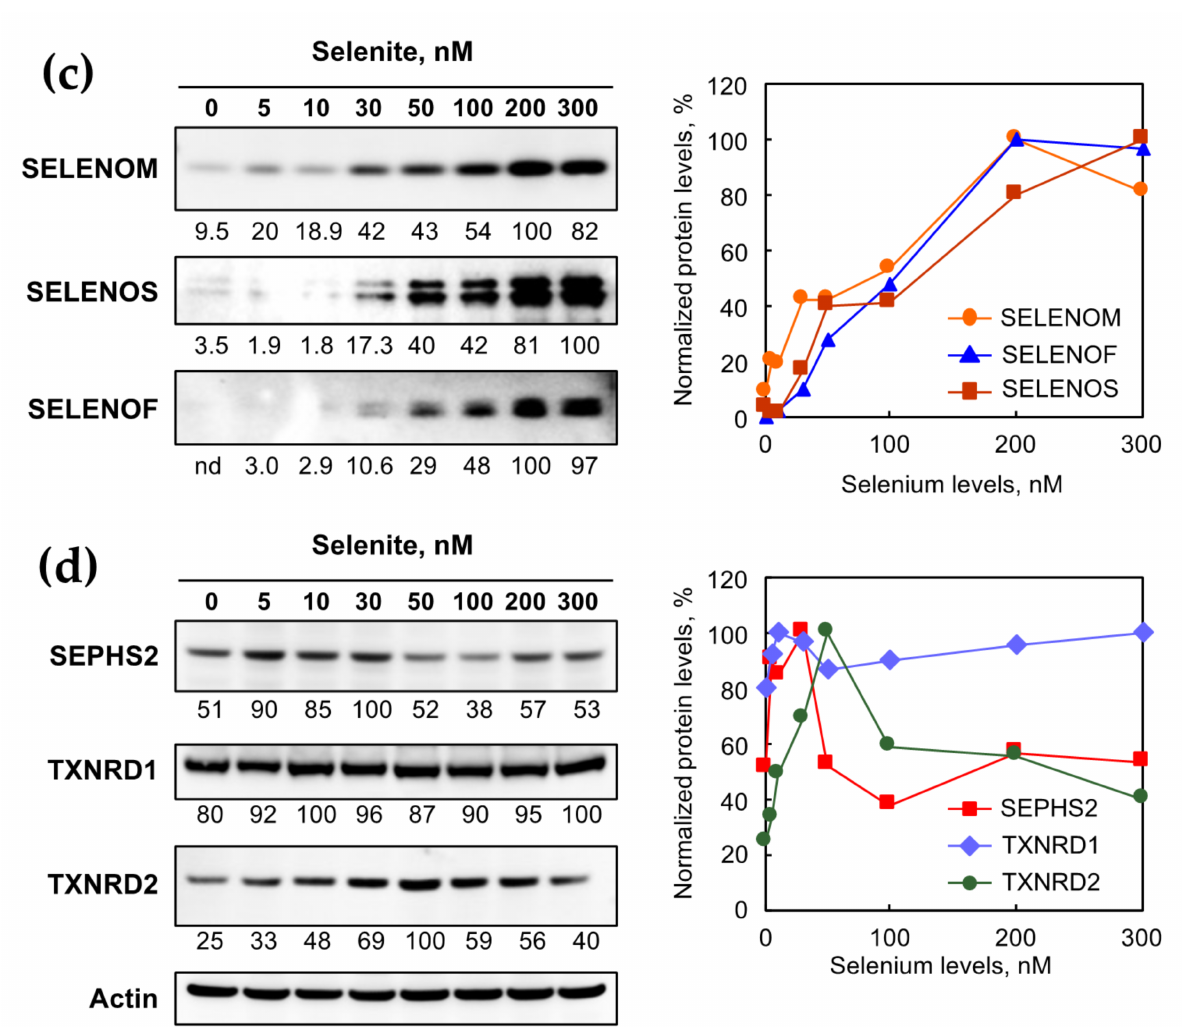
Figure 3. Analysis of selenoprotein expression as a function of selenium levels. ( a ) The response of selenocysteine insertion efficiency to selenium levels depends on the nature of the SECIS element. Two HEK293 cell lines stably expressing luciferase-based reporter constructs varying from the nature of the SECIS element, GPX1 and GPX4, respectively, were grown with increasing concentrations of selenium in the culture media. The structure of the Luc UGA/SECIS constructs was schematized. The Sec insertion efficiency was revealed by the luciferase activity normalized over the amount of proteins in cellular extracts. In both cell lines, the Sec efficiency is expressed relative to the one measured in the Dpl condition, set as 1. The HEK293 cell extracts with increasing amounts of 76 Se selenite (similar to Figure 2) were also analyzed by western immunobotting for the presence of selenoproteins GPX1, GPX4, SELENOP, and SELENOO ( b ), SELENOM, SELENOS, and SELENOF ( c ), and SEPHS2, TXNRD1, and TXNRD2 ( d ). Relative quantification of individual selenoprotein over actin is indicated at the bottom of the corresponding immunoblot, with maximum intensity set at 100. The quantification results are also represented as a function of selenium levels in the culture media and sorted into three classes. The optimal selenoprotein expression is either obtained with a low-dose (top-right panel), high-dose (middle-right panel) or in a narrow range (bottom-right panel) of selenium